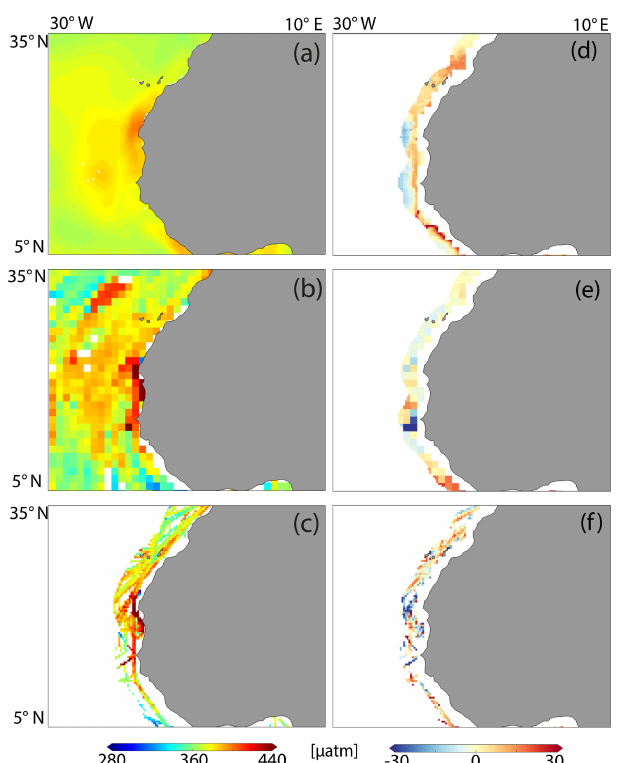
Figure 7. Mismatch analysis along the Canary upwelling region for the 1998 through 2015 period. The climatological mean p CO 2 is reported for (a) the merged product, (b) all available SOCATv5 data for the open ocean, and (c) all coastal SOCATv5 data (as illustrated in Fig. 1 for the global ocean). The p CO 2 mismatch is illustrated in (d) as the difference between NN coast and NN open . Panel (e) reports the mismatch between the NN open and the SOCATv5 open-ocean dataset along the overlap area, while panel (f) reports the mismatch between the coastal product and the SOCATv5 coastal dataset along the overlap